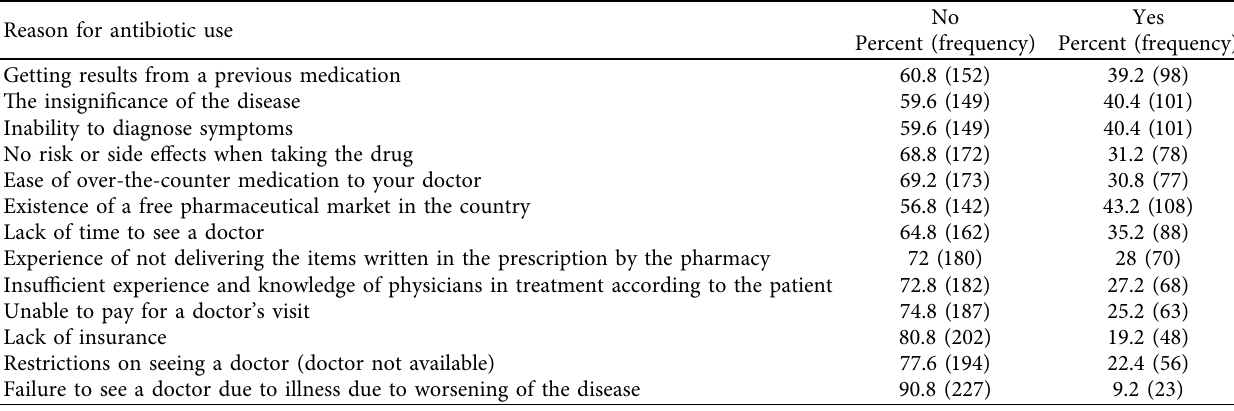
Table 3: Distribution of relative and absolute frequency of antibiotic use in the